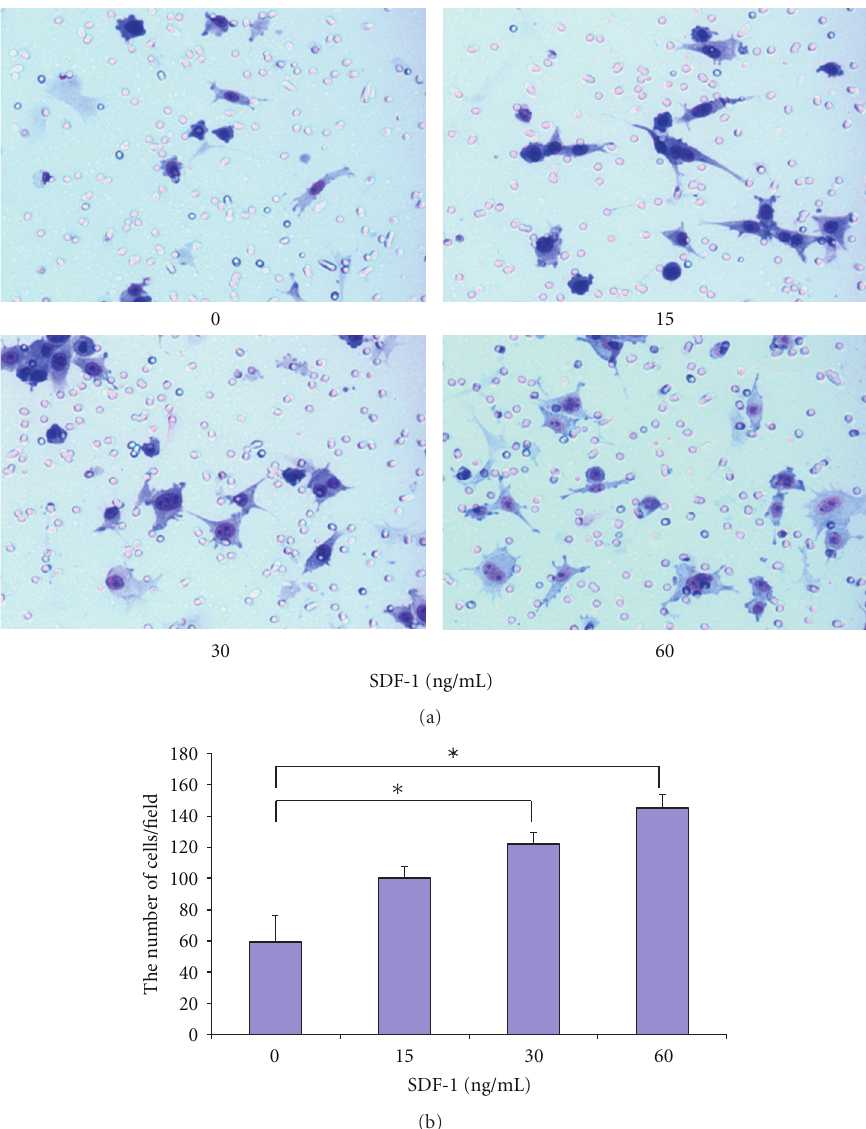
Figure 5: In vitro migration of Cxcr4-MSCs. (a) Representative images of transmigrated Mesenchymal stem cells (MSCs) stably overexpressing Cxcr4 in response to stromal-derived factor-1 (SDF-1) at concentrations of 0, 15, 30, or 60 ng/mL in transwell assay. (b) Average number of cells migrated in transwell migration assay counted in 100x magnification field. Results are mean ± SEM of 3 di ff erent fields from 3 independent experiments. The asterisks indicate statistically significant di ff erences, P < 0 . 05 (Student’s t